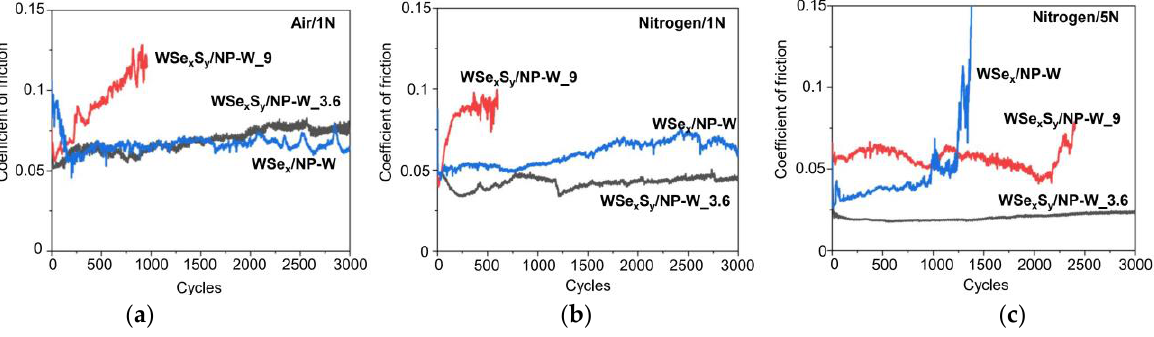
Figure 6. The friction coefficient of WSe x /NP-W, WSe x S y /NP-W_3.6, and WSe x S y /NP-W_9 coatings measured at room temperature in ( a ) air under load of 1N and N 2 -enriched environment under load of ( b ) 1N and ( c ) 5N.